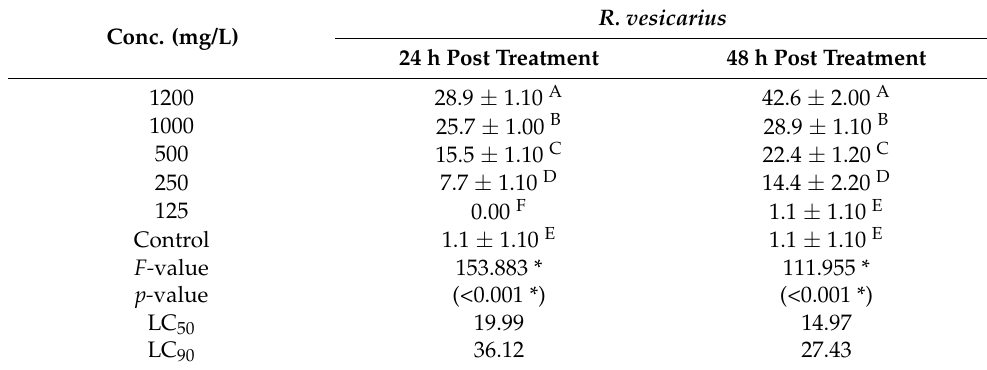
Table 5. Larvicidal effect of the methanol extract from the aerial parts of R. vesicarius on third-instar larvaef Aedes aegypti